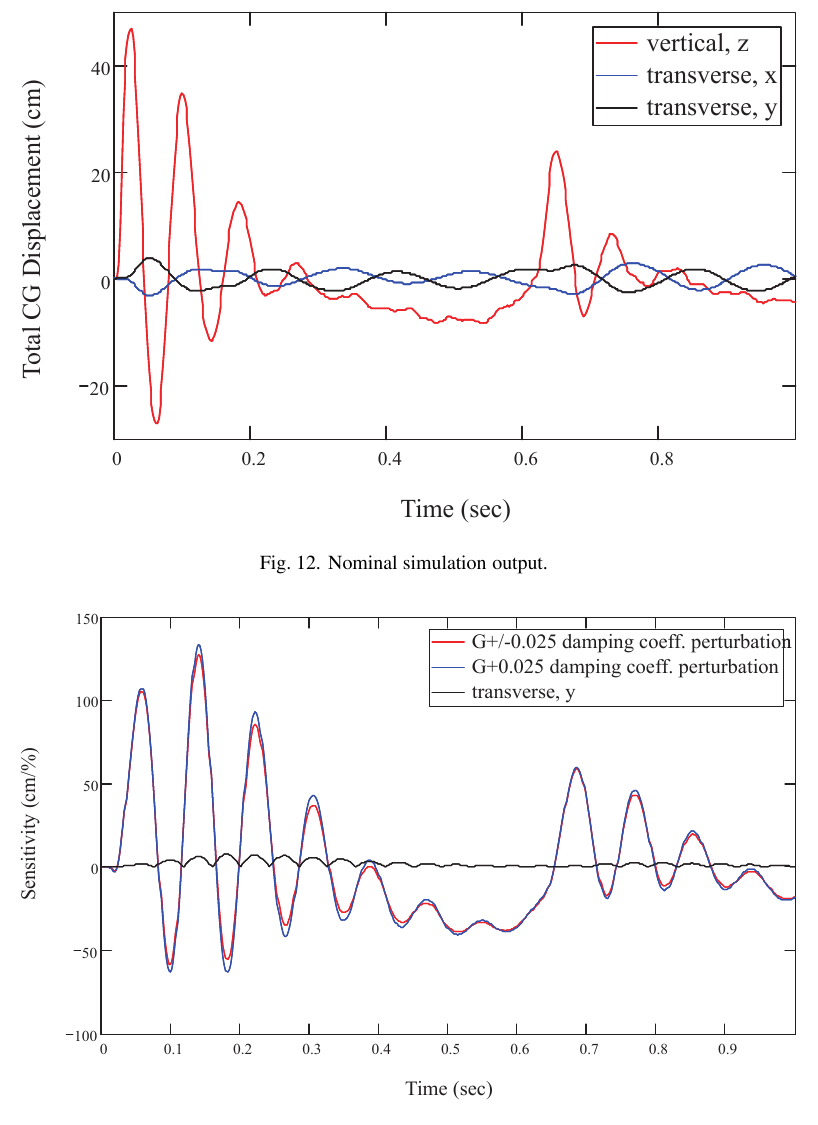
Fig. 13. Overall structural damping coef fi cient